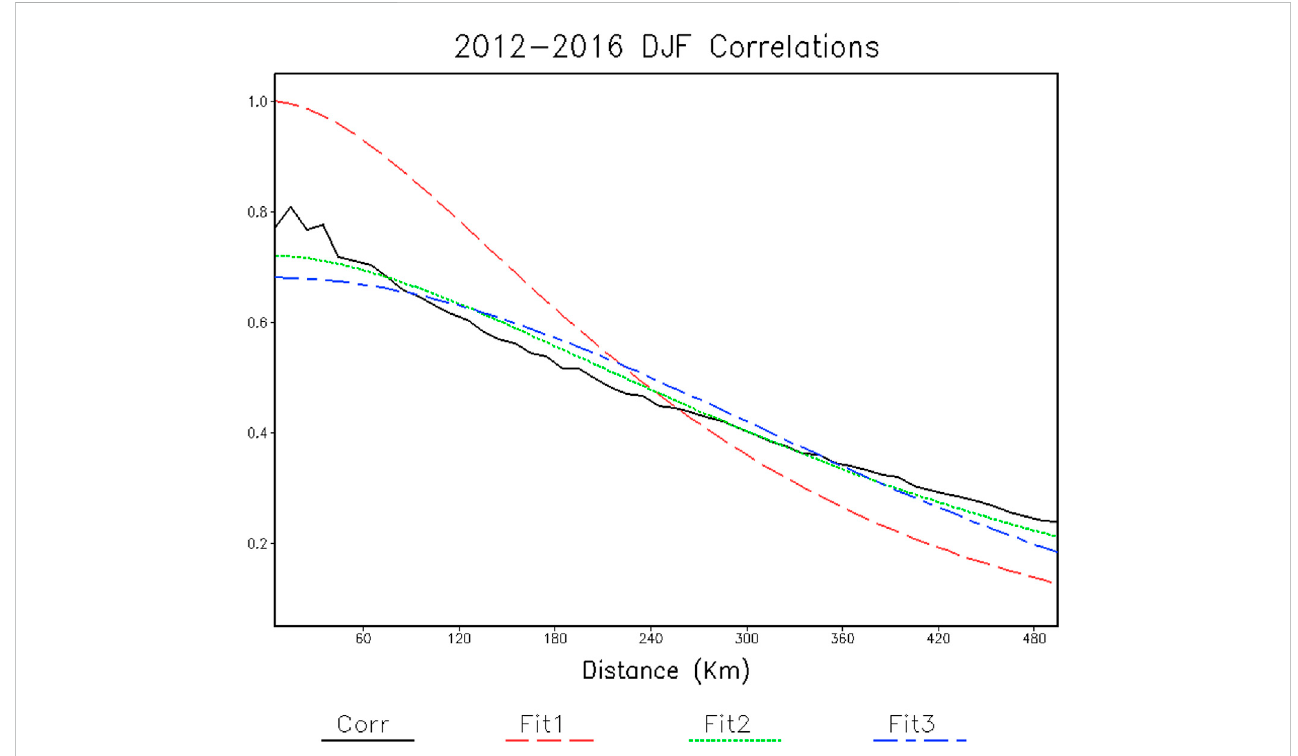
FIGURE 2 Snow depth correlations as a function of horizontal separation distance. The observed correlations, Corr, and the indicated model fi ts are shown.